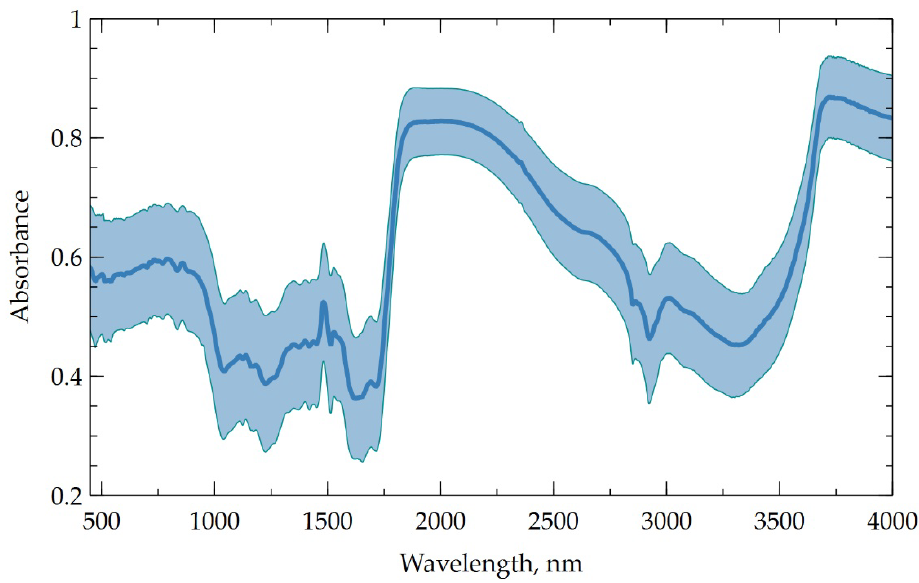
Figure 1. Averaged IR spectrum of the peat samples.